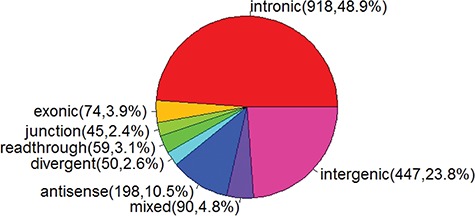
Pie chart of miRNA categories.